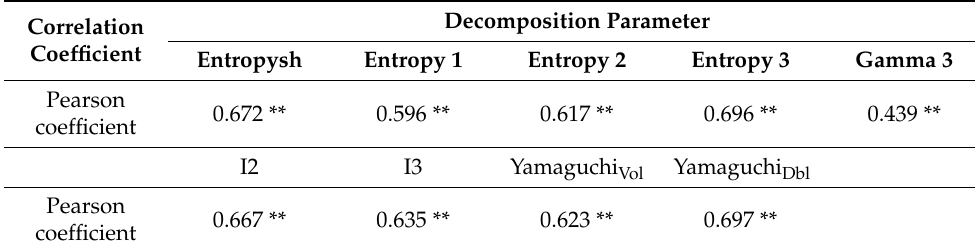
Table 7. AGB decomposition parameter correlation analysis.